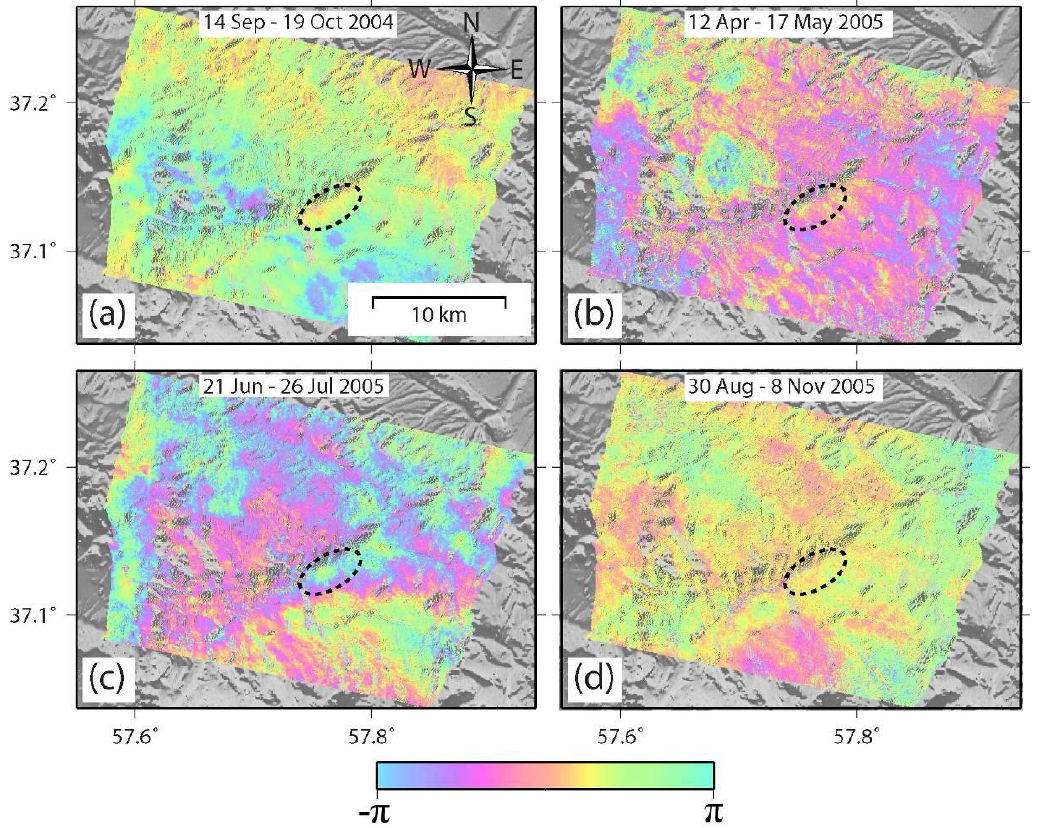
Figure 8. An example of four geocoded differential interferograms from the cropped part of SAR data after removing orbital and topography effects; black dotted ellipses indicate the location of Sarcheshmeh slope in the interferograms. One full color cycle, representing a difference in phase of −π to π, corresponds to 2.8 cm of LOS range